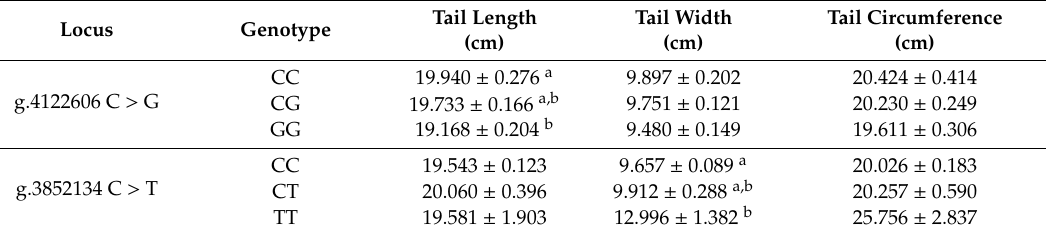
Table 2. Association analysis of PDGF-D gene with tail